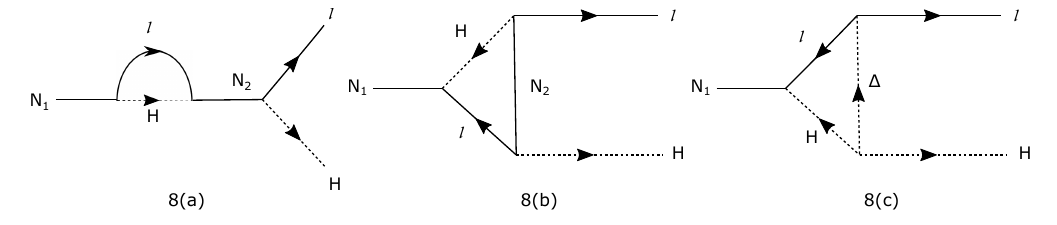
Figure 8 . One loop-level diagrams contributing to CP asymmetry.